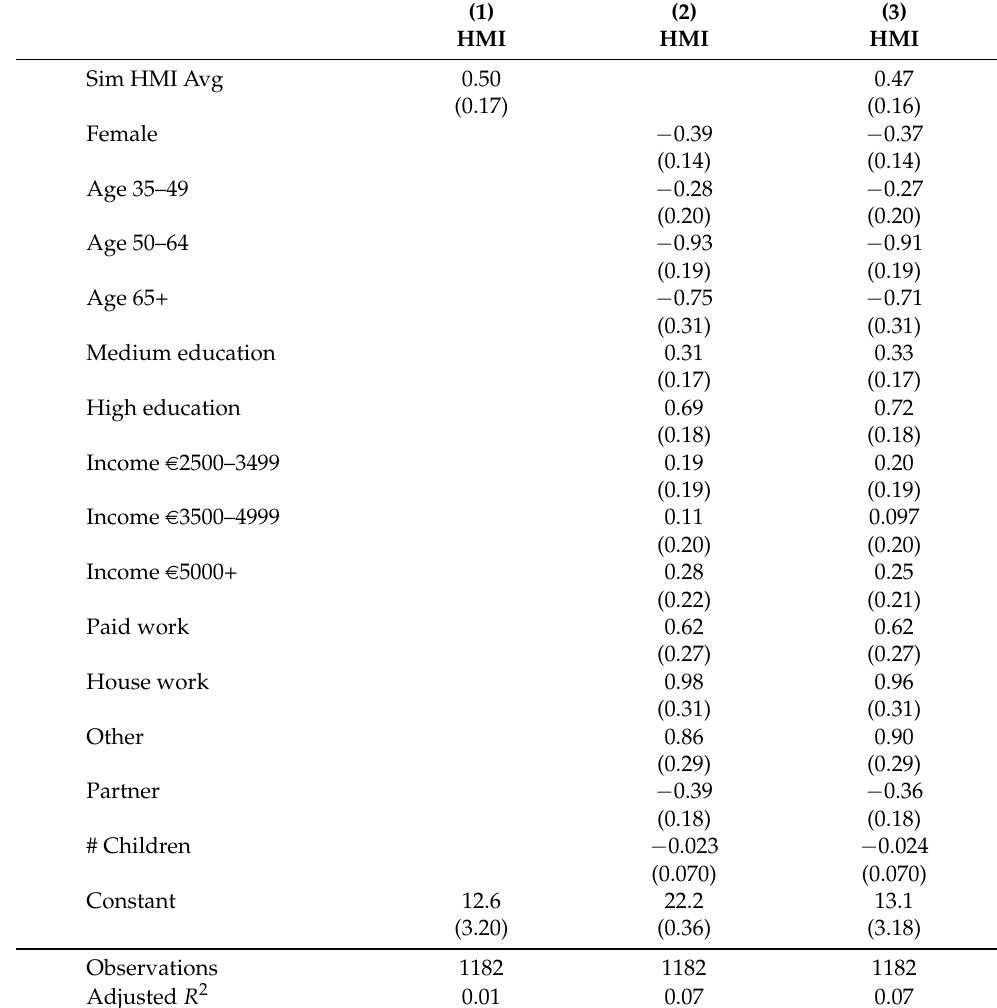
Table 2. Regressions with